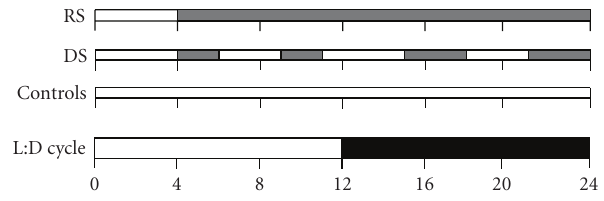
Figure 1: Schematic overview of the sleep disturbance protocols for the restricted sleep group (RS), disturbed sleep group (DS), and control group. For each treatment group, periods of wakefulness induced by forced locomotion are shown in light grey. The RS group was subjected daily to one consolidated block of 20-hour forced activity while the DS group was subjected to blocks of 2-3- hour forced activity interspersed by 3-4-hour blocks of rest. Control animals were left